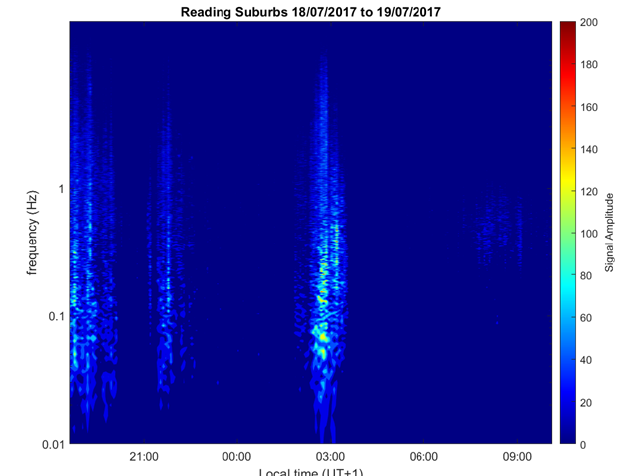
Figure 3. A spectrogram of infrasound data obtained by an IN- FRA20 sensor situated in the southeastern Reading suburbs from 18 July 2017 to the morning of the 19 July 2017. (On the x axis is the local time in hours; on the y axis is the frequency of the infra- sound signals. The colour bar on the right shows the strength of the infrasound signals.).